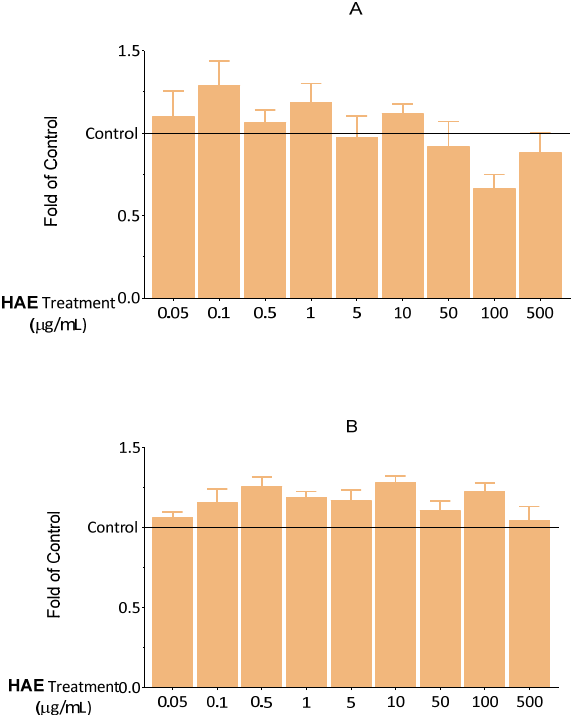
Figure 2. Viability of HUVECs was examined after 24 ( A ) and 48 ( B ) hours using an MTT assay. The results are expressed relative to the control (Control = 1; 0 µg/mL HAE). Data are expressed as the mean ± SEM of four individual experiments. The thin grey solid line indicates the control level (Control = 1). Differences were considered statistically significant when p < 0.05. We did not observe any statistically significant di ff erences.